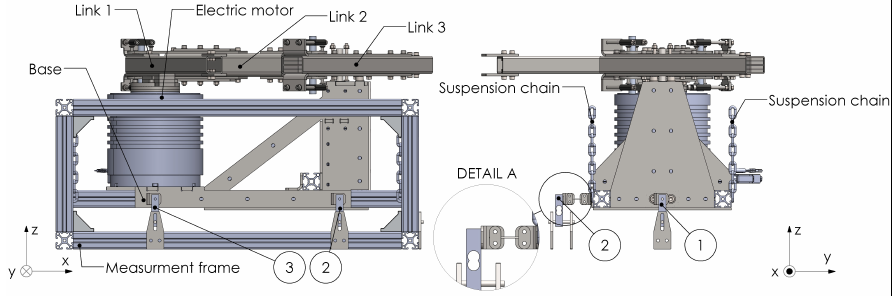
Figure 12. CAD model of the experimental setup with the manipulator base suspended by chains to allow for small in-plane motions of the base. The numbers denote the positions of the load cells. In the right figure the measurement frame is hidden. Detail A shows the connection of a thin rod between a load cell and the manipulator